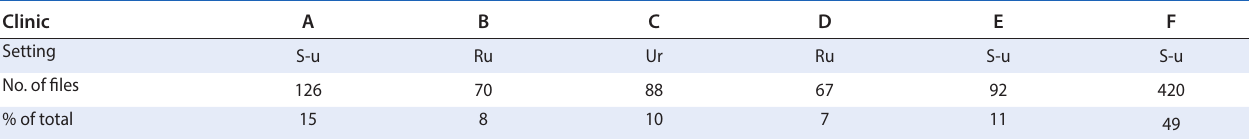
Table 1: The sample size and type of setting of each clinic in the sample Clinic